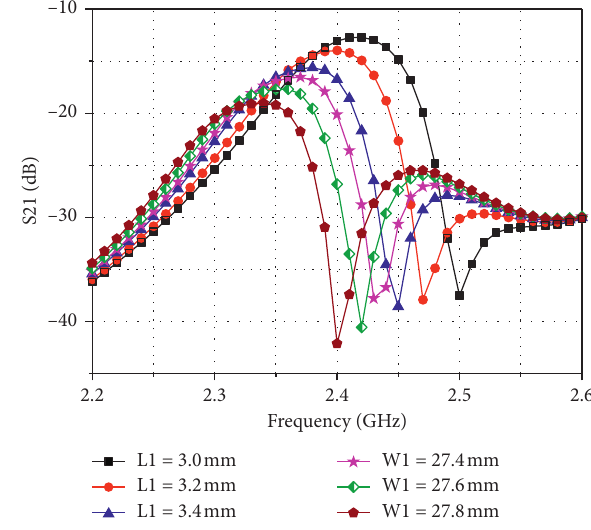
Figure 2: Relationship between E-shaped stub parameters and S